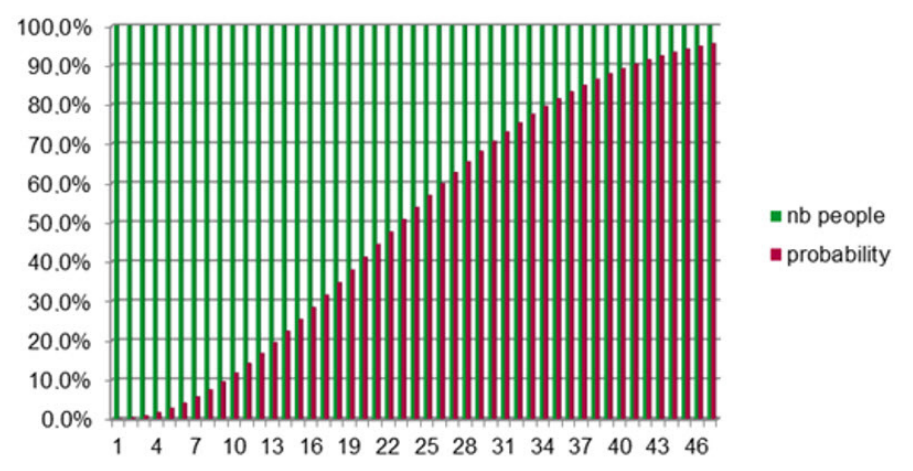
Figure 1. Solving the birthday paradox task for different n (“nb” means “number